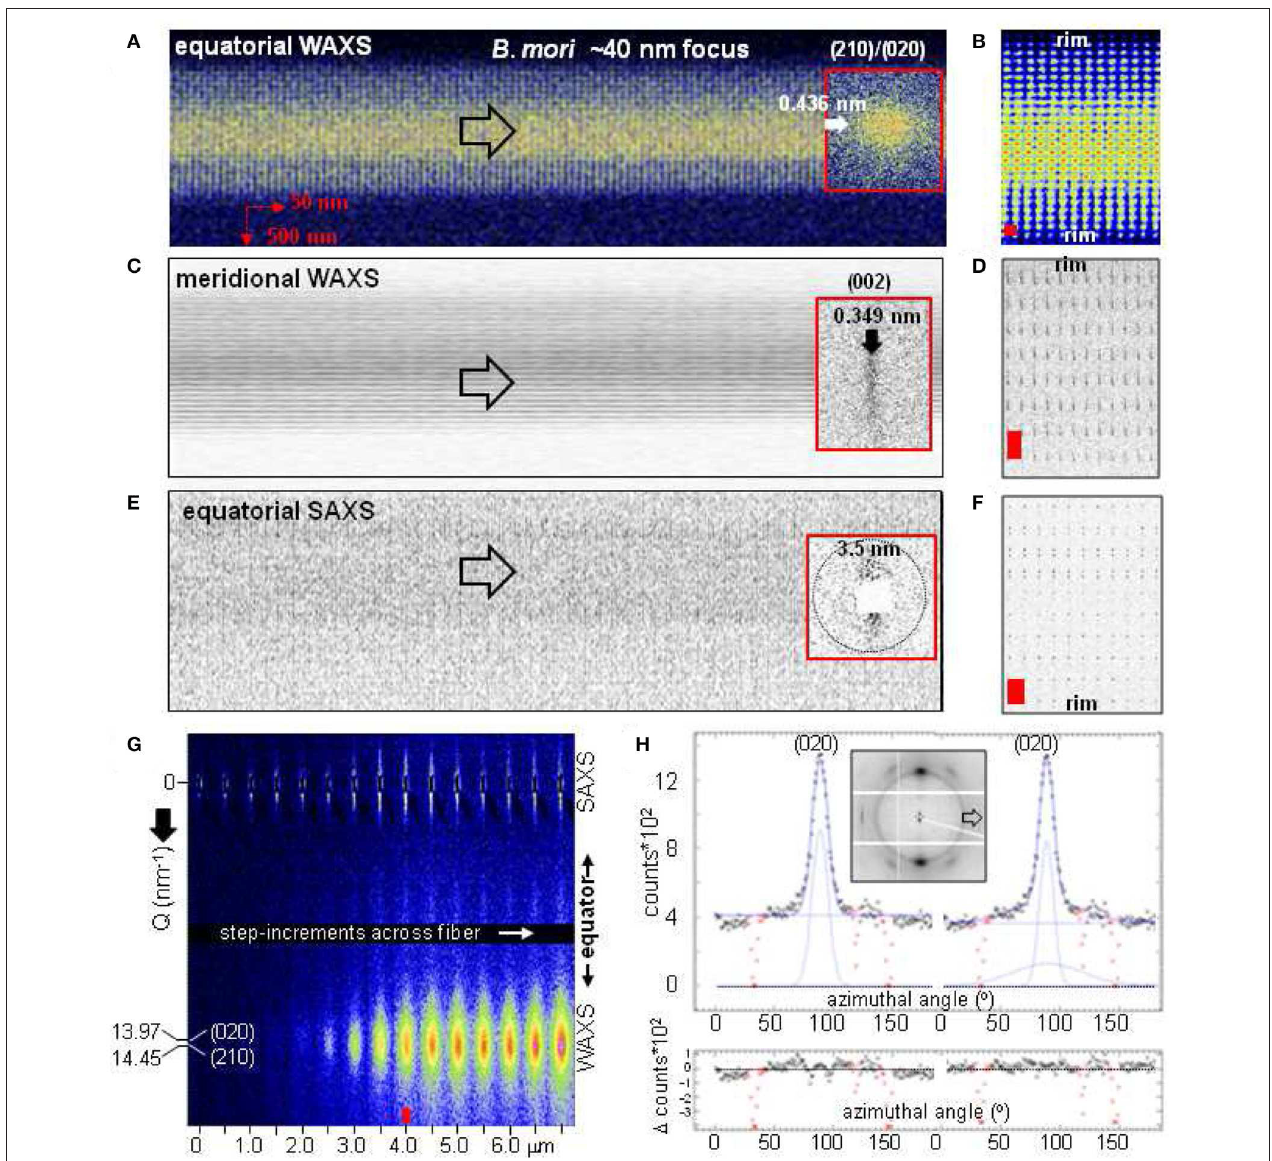
FIGURE 5 | Composite images of B. mori bave based on 50 nm hor × 500 nm ver raster-steps through a 50 nm hor × 35 nm ver focus. Note that the two fibers are nearly overlapping in projection. Insets: patterns from the center of the bave. (A) Based on (210)/(020) Bragg peaks. (C) Based on the (002) Bragg peak. (E) Based on the equatorial SAXS streak. Open arrows along fiber axis. (B,D,F) Zooms of composite images to the left (distorted for better viewing). Red rectangles correspond to step-increments. (G) Pseudo line-scan across part of the bave covering the equatorial SAXS streak and the (020)/(210) peaks. The upper part of the streak is partially extinguished due to a scattering artifact (image expanded vertically by about factor 5). (H) Fit of azimuthal profile through (020) peak (inset) for pattern indicated by red arrow in (G) by Gaussian and 0-order polynomial functions. Fit by single Gaussian to the left; fit by two Gaussians with different width to the right. Inactive detector areas (in red) masked for the